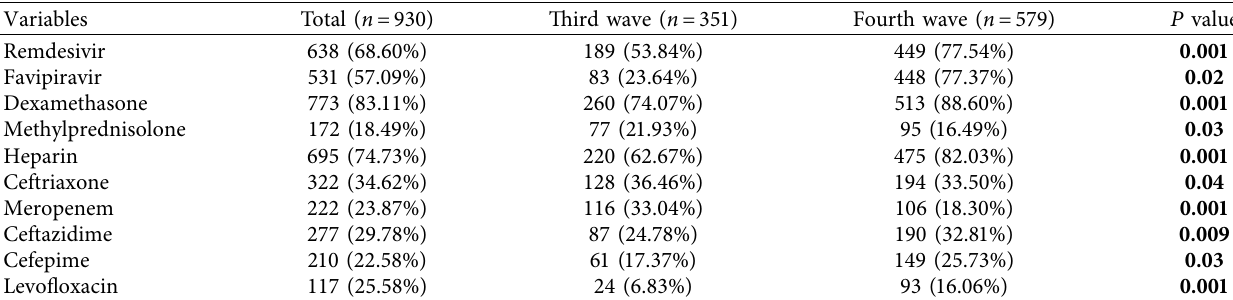
Table 2: Comparison of medication prescribing among third and fourth wave COVID-19